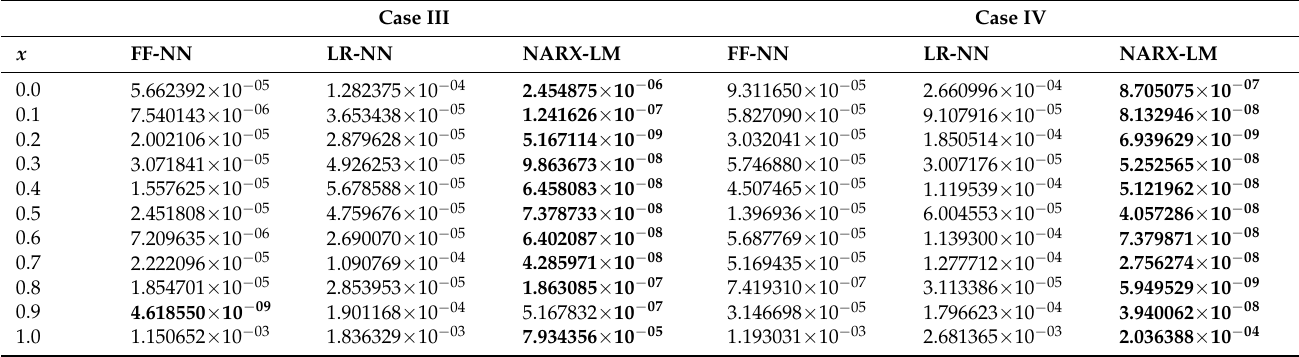
Table 4. Comparison of the absolute errors in solutions for the concentration of PGE obtained by the NARX-LM algorithm with different machine learning techniques for Case III and